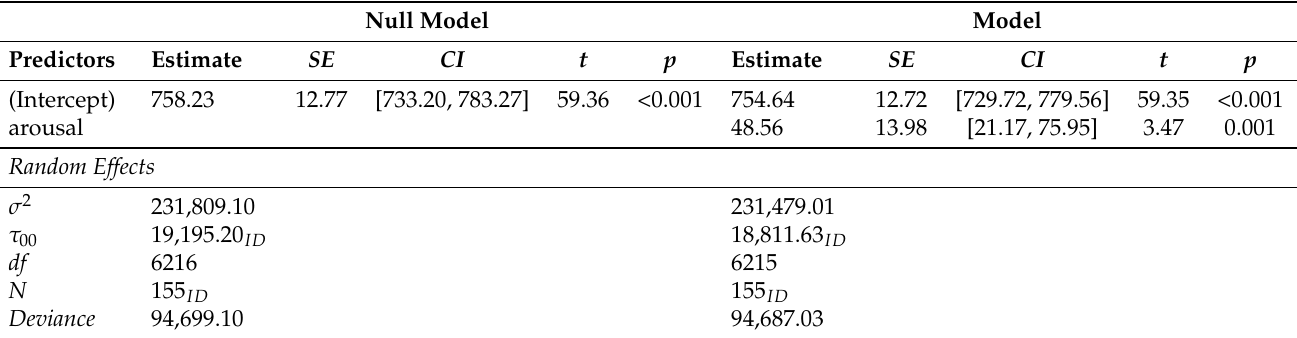
Table A11. Mixed model of the influence of emospace arousal widget response vector results on the GSR response latency.